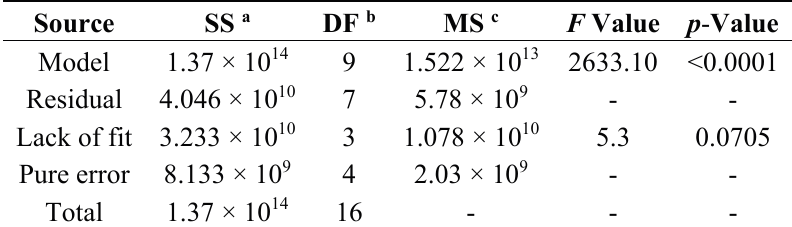
Table 3. ANOVA of the quadratic polynomial.